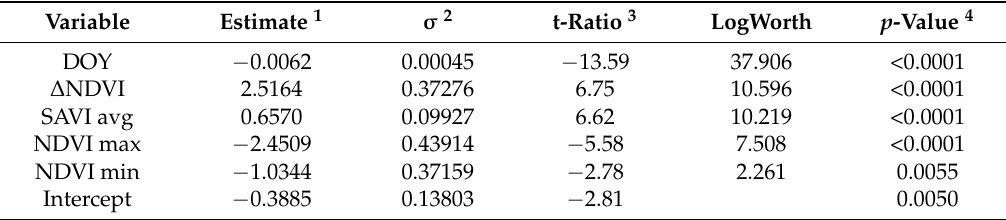
Figure 9. Results of predicted (using the ‘global’ multivariable regression model) vs. observed Ψ stem in the 82 vineyards along the 2017 growing (dashed line indicates 1:1 slope). Table 3. Size effects (LogWorth) and estimates of the variables used in the ‘global’ multivariable regression model (i.e., the coefficients of the variables used in the linear model). The table was arranged from the variable with the highest to the lowest effect in the